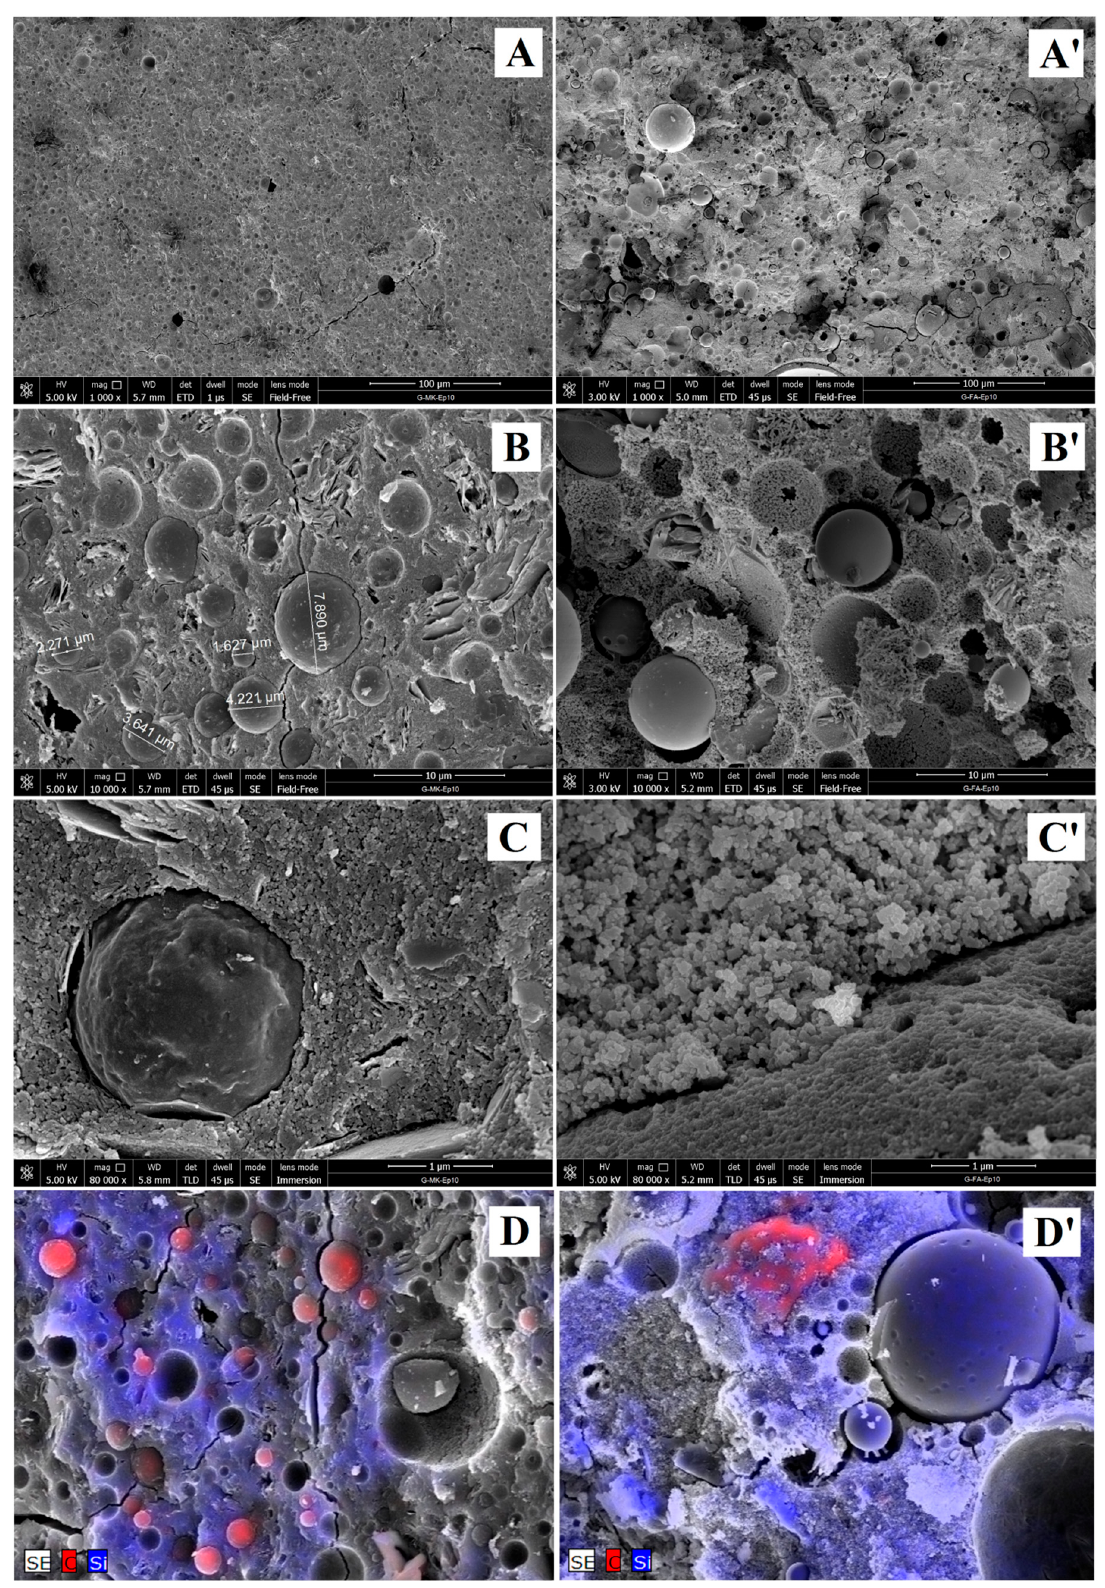
Figure 7. Scanning electron microscope (SEM) micrographs of MK -based geopolymer composites (G-MK-Ep10; ( A – C )) and FA-based geopolymer composites (G-FA-Ep10; ( A’ – C’ )). In ( D , D’ ), the EDS maps (at 5000 magnification) of silicon (in blue ) and carbon (in red ) of two representative regions of the G-MK-Ep10 and the G-FA-Ep10 sample are shown, respectively.